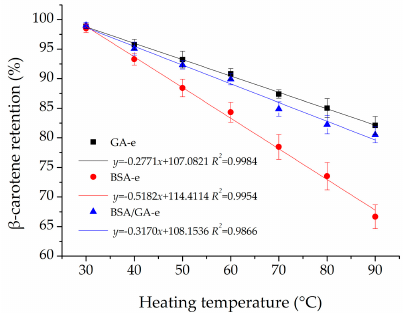
Figure 3. The effects of heating temperature on the β -carotene retention of the three emulsions studied. The temperature of the three emulsions studied were adjusted to 30 °C, 40 °C, 50 °C, 60 °C, 70 °C, 80 °C, 90 °C separately and they were stored without light for 2 h. β -carotene retention was then measured after storage. Each data point is an average of triplicate, and the standard deviations are given. Solid lines represent the fitting results from the linear equation using OriginPro.